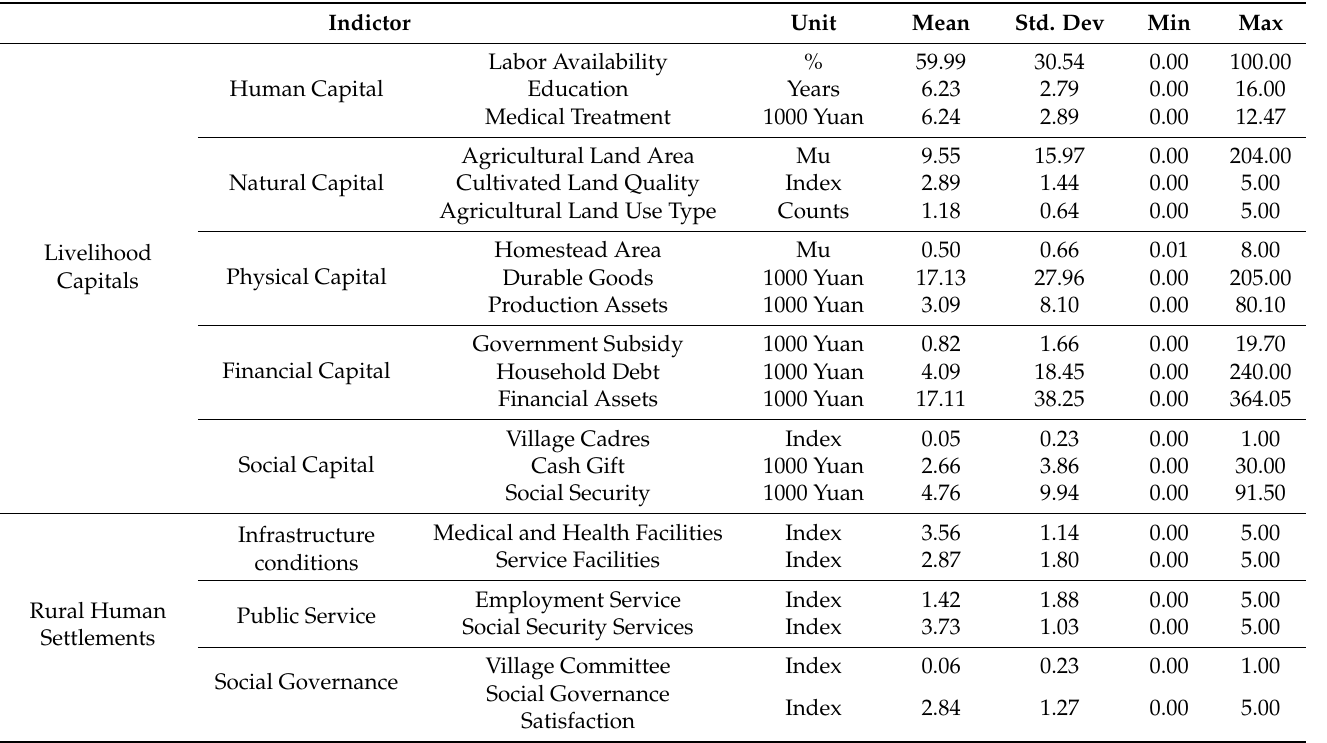
Table 4. Descriptive statistics for the explanatory